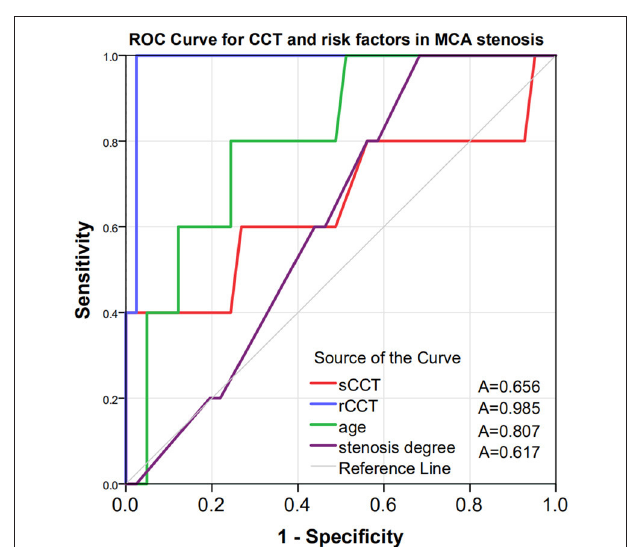
FIGURE 3 | Receiver operating characteristic curves to evaluate the utility of CCT and traditional risk factors in predicting DICE in patients with ND-MCAS. The AUC was 0.985 for rCCT (blue curve), 0.656 for sCCT (red curve), 0.807 for age (green curve) and 0.617 for stenosis degree (purple curve). CCT, cerebral circulation time; sCCT, CCT of the stenotic side; hCCT, CCT of the healthy side; rCCT, relative CCT = CCT of the stenotic side/CCT of the healthy side; A, area under the curve; ROC, receiver operating characteristic; DICE, disabling ischemic cerebrovascular events; ND-MCAS, non-disabling middle cerebral artery